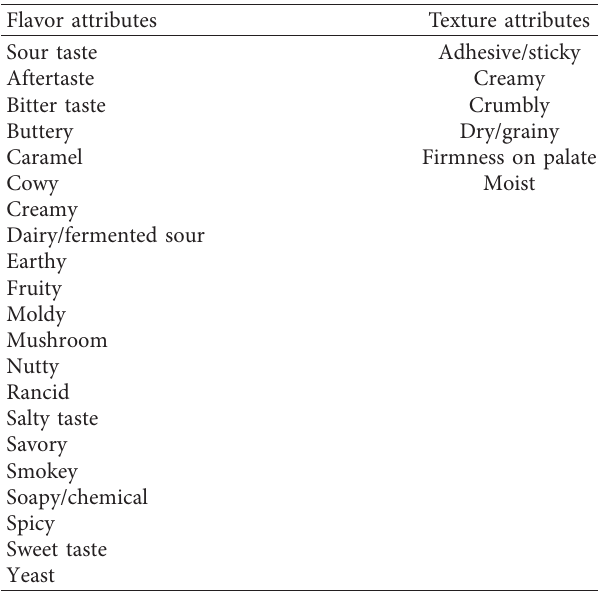
Table 2: List of flavor and texture attributes used for the sorting